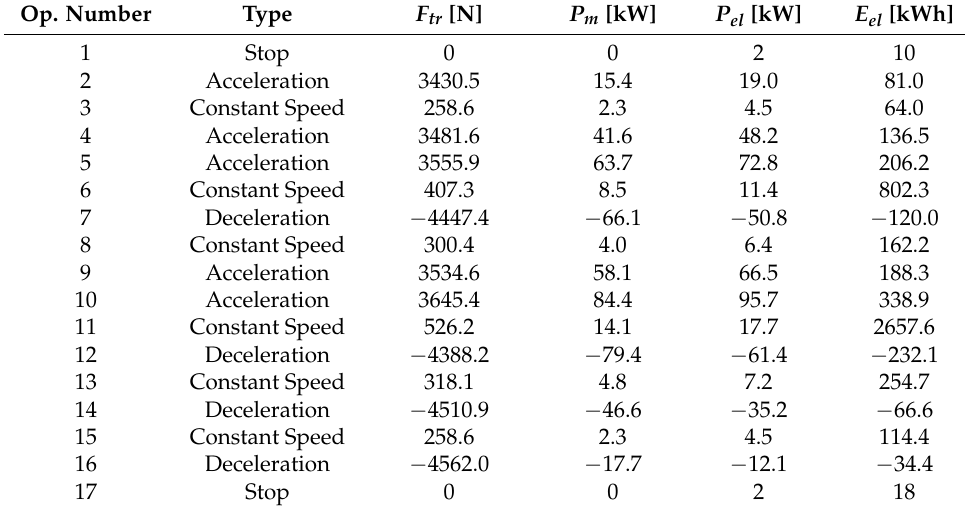
The numerical results for the elementary extra-urban cycle, for each phase of the cycle, are highlighted Table 8. Then, the numerical results, which are reported in Tables 7 and 8, are used to analyze the above defined mobility patterns. Table 8. Energy Quantities of the chosen elementary extra-urban cycle. Op. Number